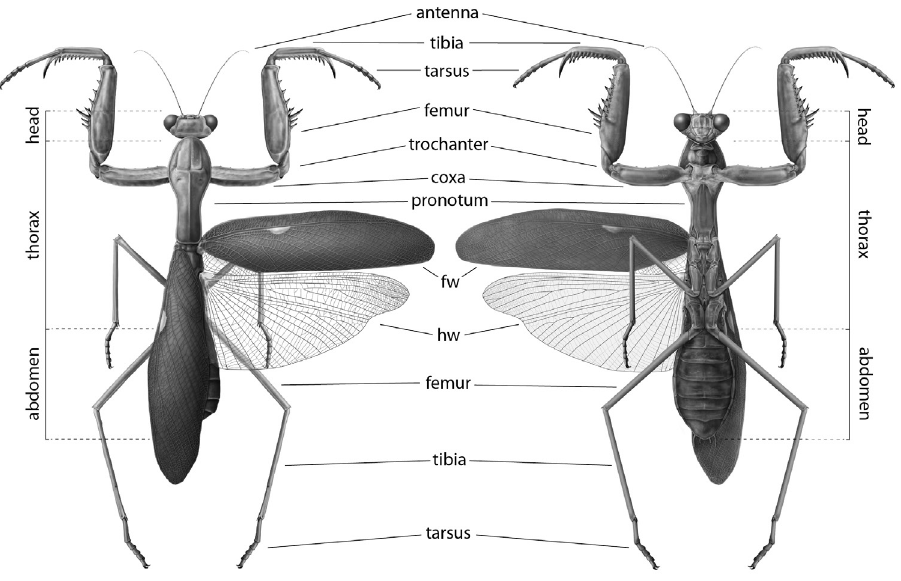
Figure 1. Carbon dust illustrations of Sphodromantis sp. dorsal and ventral habitus, from left to right respectively. Illustrations by Rebecca Konte. Abbreviations: fw = forewing; hw =